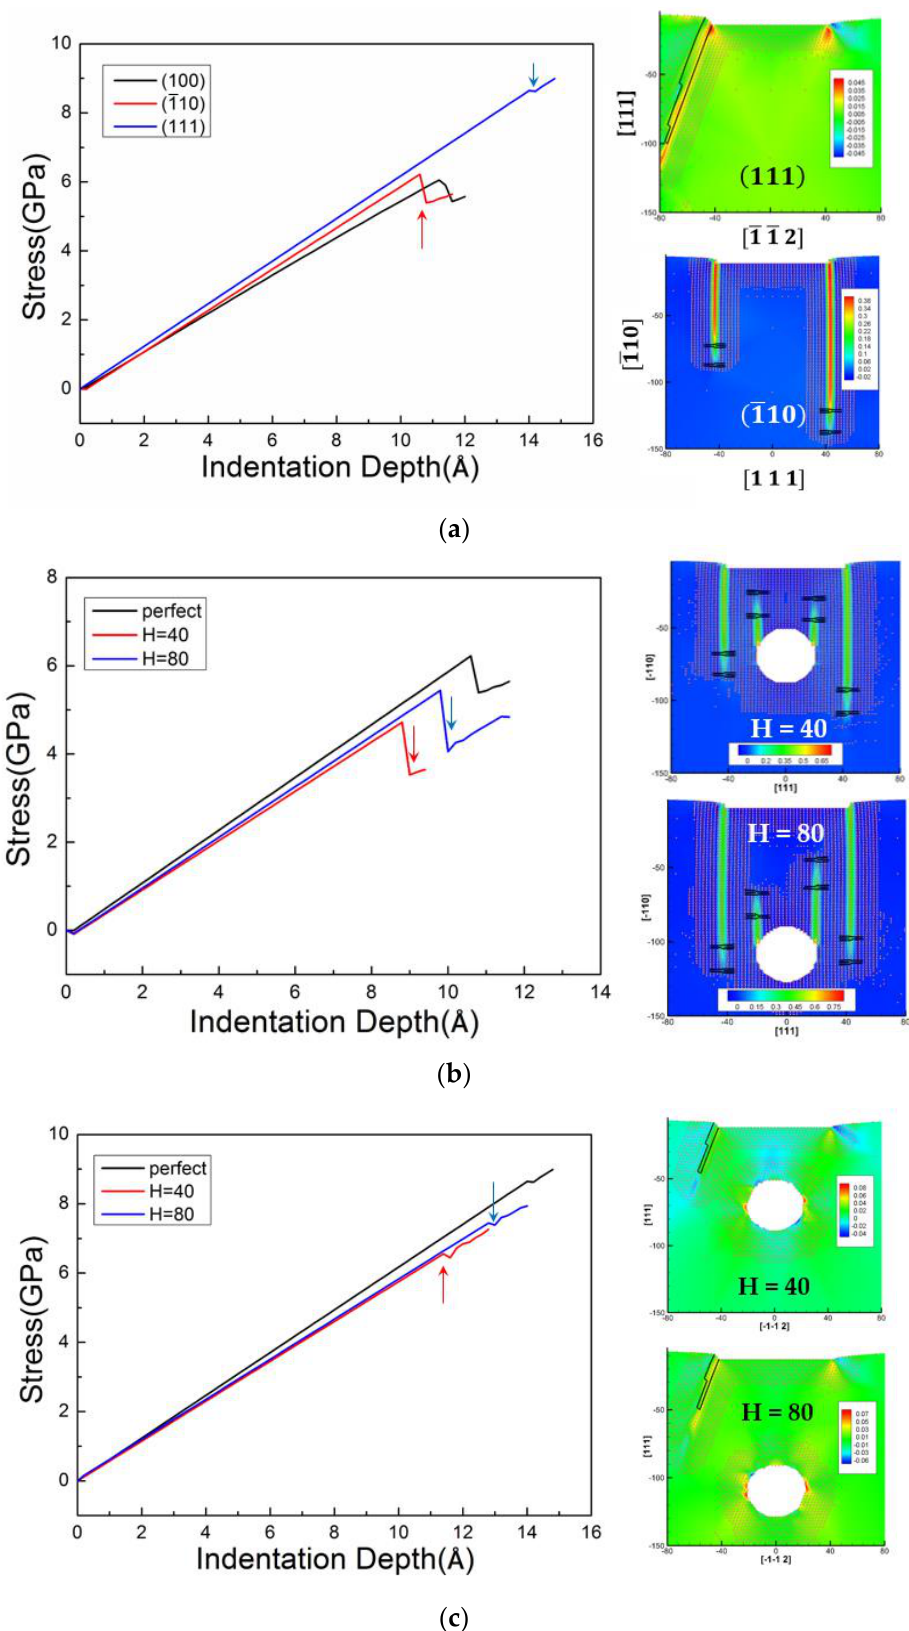
(cid:0) (cid:1) Figure 8. Stress–displacement curves of nanoindentation ( a ) on the (001), 110 and (111) surfaces of (cid:0) (cid:1) a perfect Al single crystal, ( b ) on the 110 and ( c ) on the ( 111 ) surface of a perfect Al single crystal and Figure 8. Stress–displacement curves of nanoindentation ( a ) on the (001), (1̅10) and (111) surfaces of two matrixes with a nanocavity ( D = 40 Å, H = 40 Å) and ( D = 40 Å, H = 80 Å) respectively. The side a perfect Al single crystal, ( b ) on the (1̅10) and ( c ) on the (111) surface of a perfect Al single crystal insets are dislocation morphology at the initial yielding and two matrixes with a nanocavity ( D = 40 Å , H = 40 Å ) and ( D = 40 Å , H = 80 Å ) respectively. The side insets are dislocation morphology at the initial yielding point.